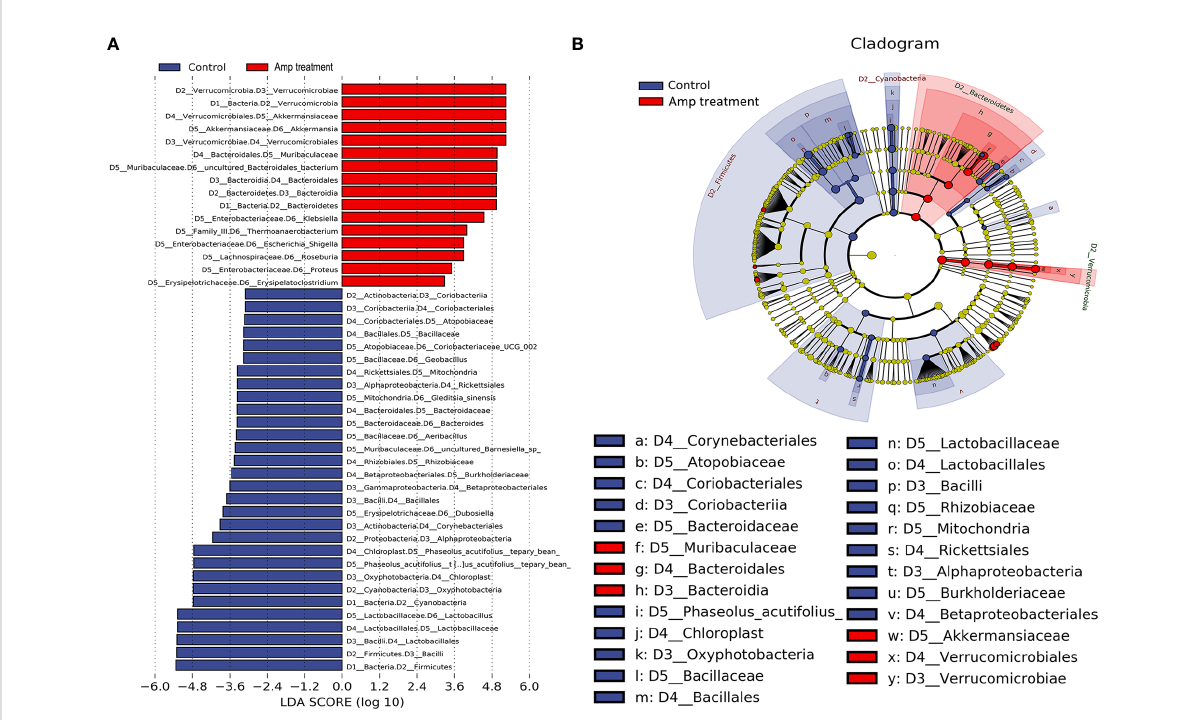
FIGURE 7 Line discriminant analysis (LDA) effect size (LEfSe) histograms and cladograms between two groups. (A) The histogram of LDA value distribution (LDA Score >3) shows the genus with signi fi cant differences between control and Amp treatment group. (B) The LEfSe cladogram shows the evolutionary relationships between genus with signi fi cant differences between thecontrol and Amp treatment